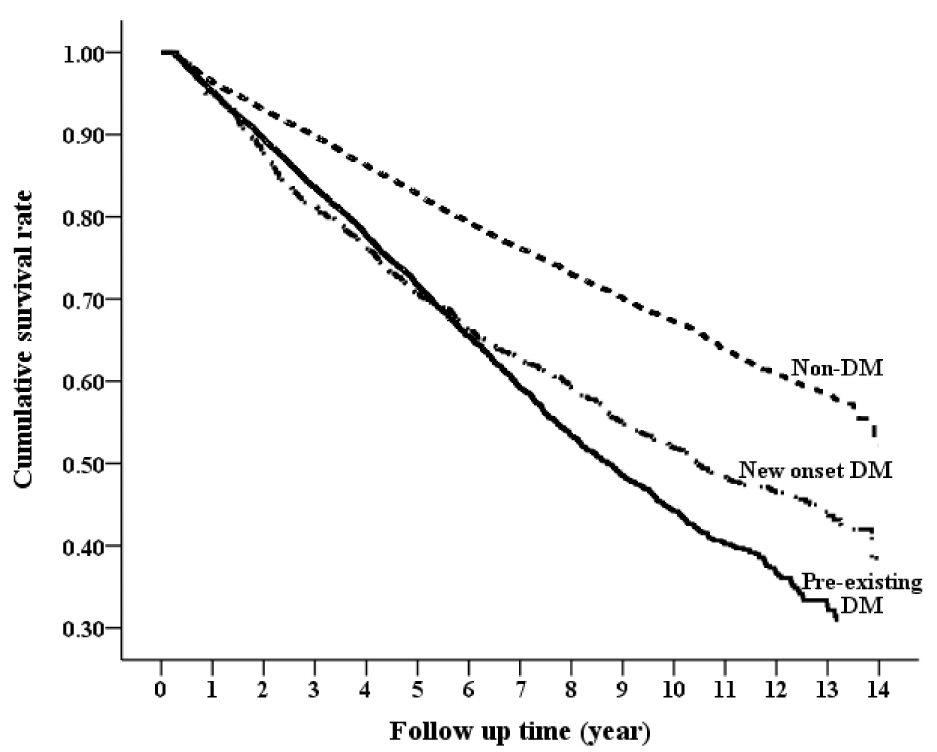
Figure 3. Cumulative overall survival curves between pre-existing DM, non-DM, and incident DM